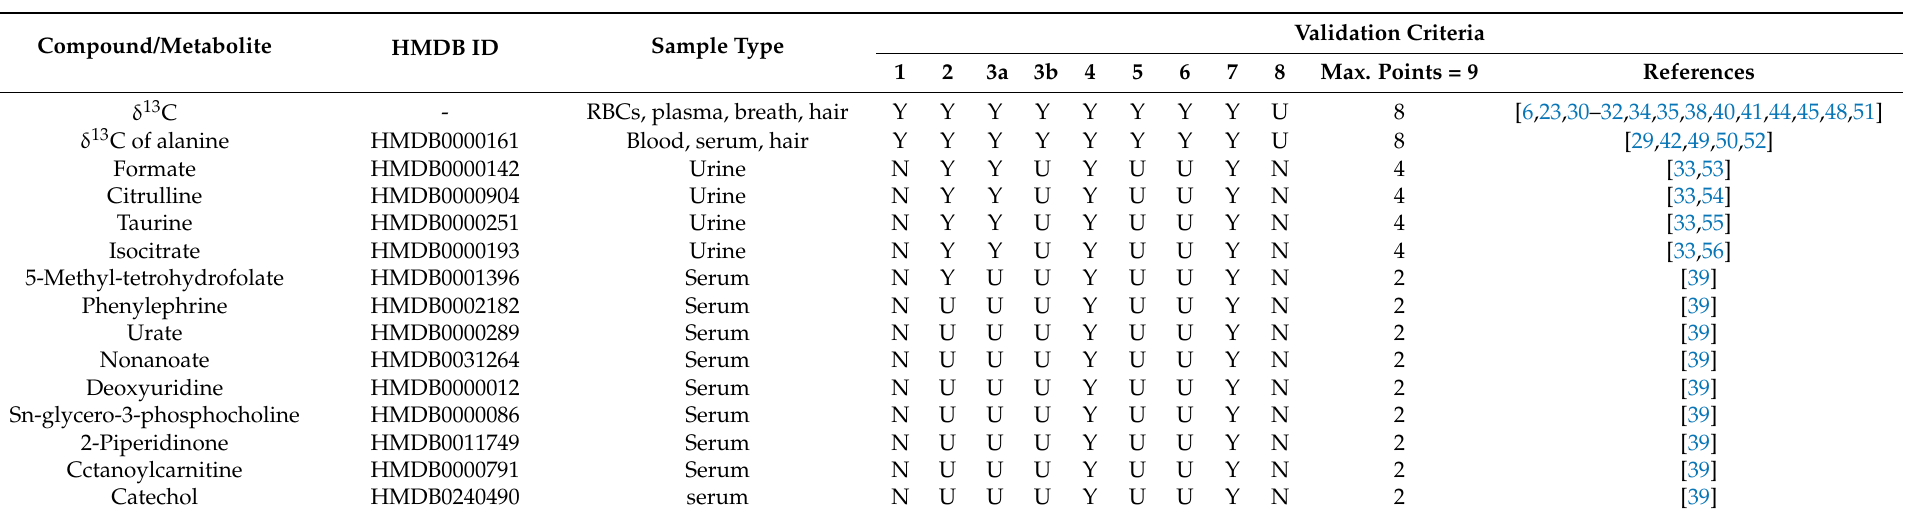
Table 2. Evaluation of the validity of the identified candidate biomarkers for dietary intake of